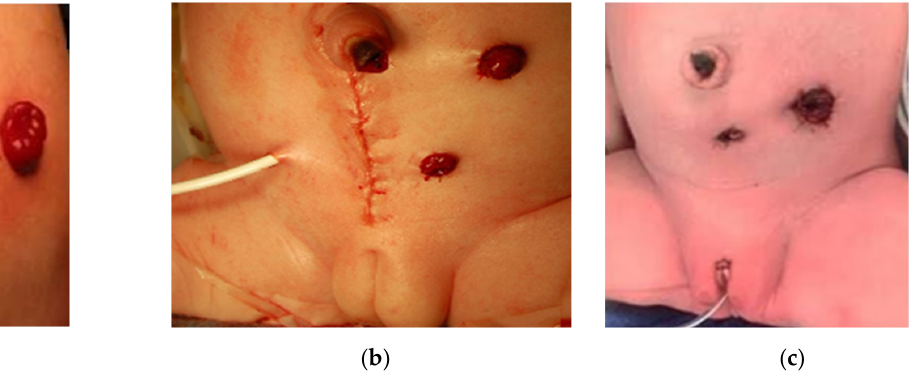
Figure 6. Panels show different techniques for colostomy creation in newborns with cloacal anomaly: ( a ) divided sigmoid colostomy with colostomy matured at the superior pole of the incision and a small, flat mucous fistula at the inferior pole with sufficient distance in between for pouching; ( b ) a low midline incision was made for surgical placement of a vaginostomy tube at the same time; therefore, separate incisions for the stoma ends were made like the laparoscopic technique shown in ( c ) a laparoscopic approach allows for two separate incisions.